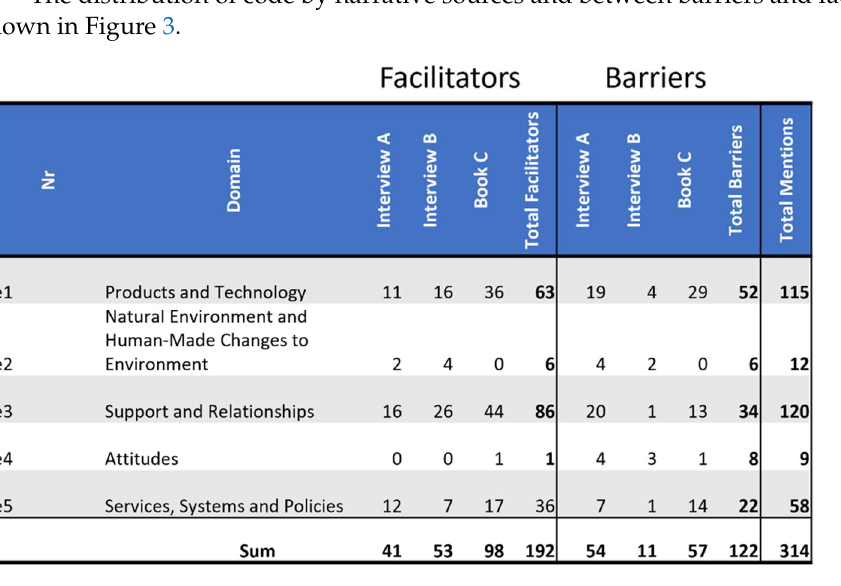
Figure 3. Distribution of codes by ICF domains: This figure shows the frequency of references by domains as facilitators and as barriers. Additionally, it tallies all references as facilitators or as barriers by source, as well as facilitators and barriers both separately and together by domain.